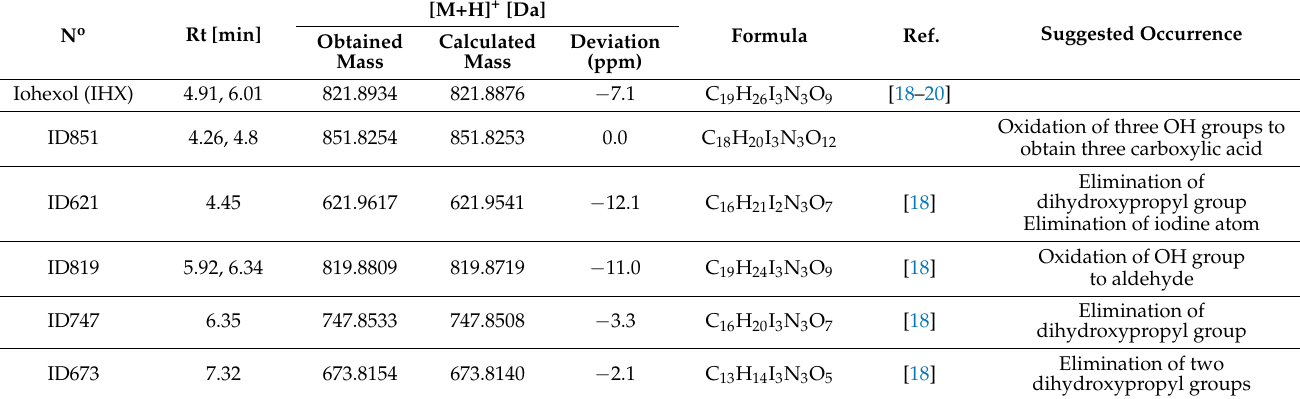
Table 2. Iohexol transformation products’ identification